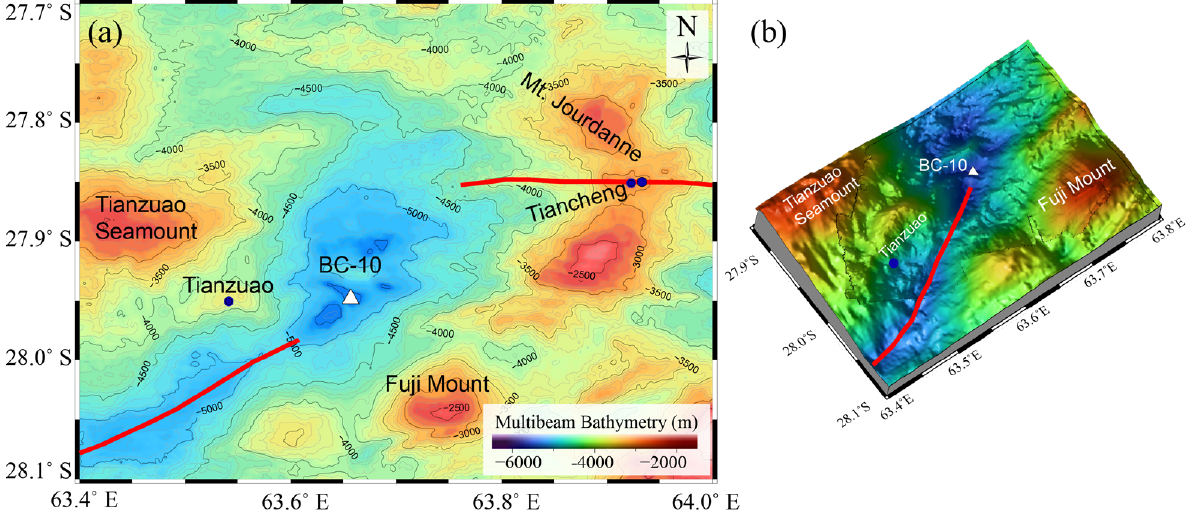
Figure 2. Bathymetric maps showing the location of the BC-10 sampling station. ( a ) Colour−coded bathymetric map with 100 m contours highlighting the topographic features surrounding the sam- pling location. The ridge segments are shown as red lines. The reported hydrothermal fields are marked with blue circles. ( b ) A 3D perspective map of the study area was prepared using the multibeam data collected during the MGS-25 expedition.